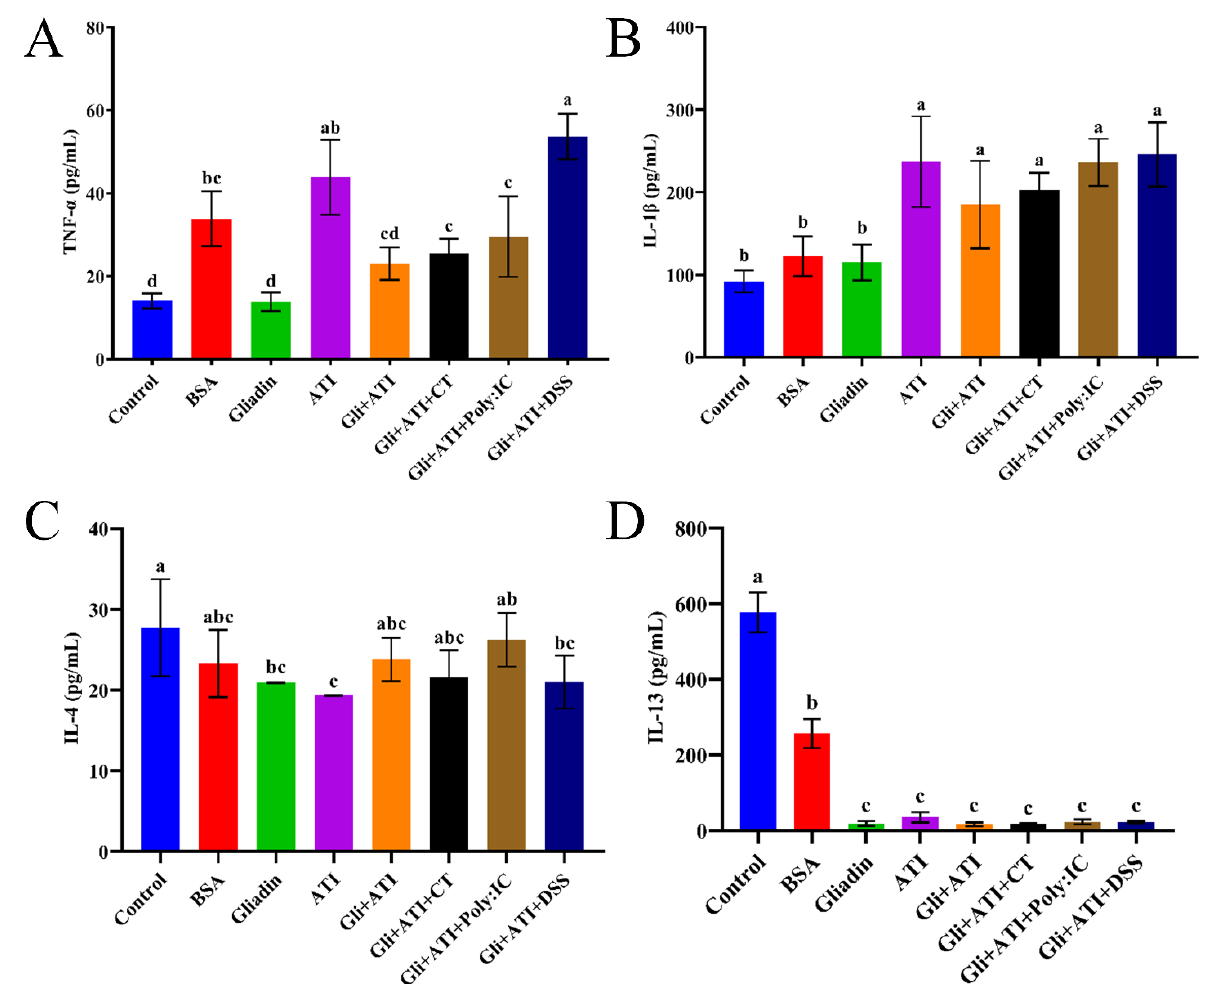
Figure 6. The level of ( A ) Tumor necrosis factor- α (TNF- α ), ( B ) Interleukin-1 β (IL-1 β ), ( C ) Interleukin-4 (IL-4) and ( D ) Interleukin-13 (IL-13) cytokines in spleen cell cultures of mouse. Different letters represent significant differences ( p < 0.05) between groups.